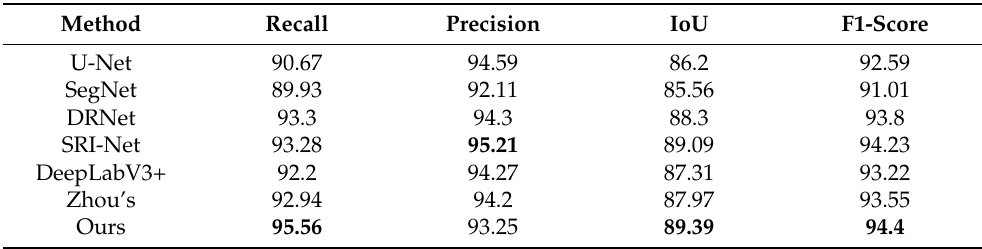
Table 1. Quantitative comparison results (%) among our method and the other six classical building extraction methods tested on the WHU